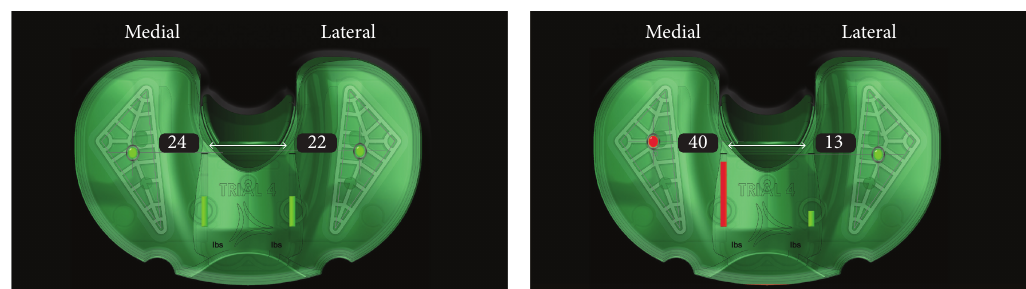
Figure 1: Coronal plane “balance” was defined as a mediolateral intercompartmental loading difference of ≤ 15 pounds; all transtibial loading exceeding 15 pounds of mediolateral intercompartmental difference was classified as “unbalanced.”